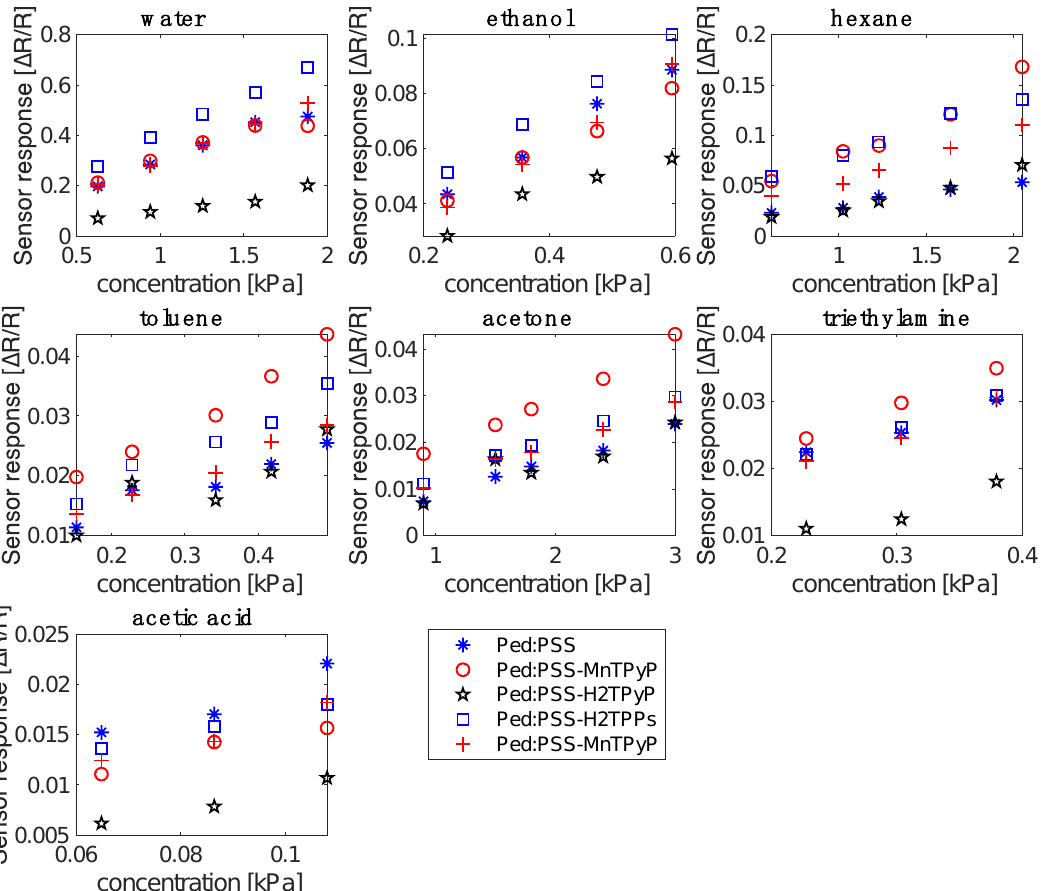
Figure 4. Response curves to the seven studied volatile compounds.